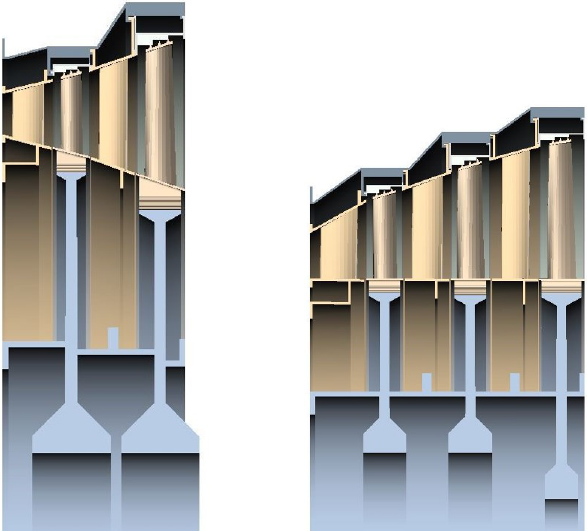
Figure 6. Low-pressure turbine